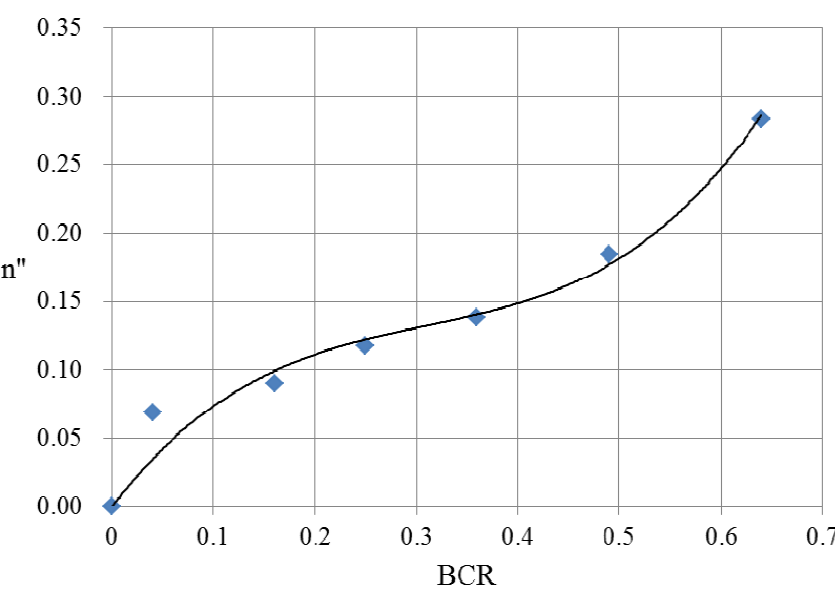
Figure 7. Relationship between n and BCR under different